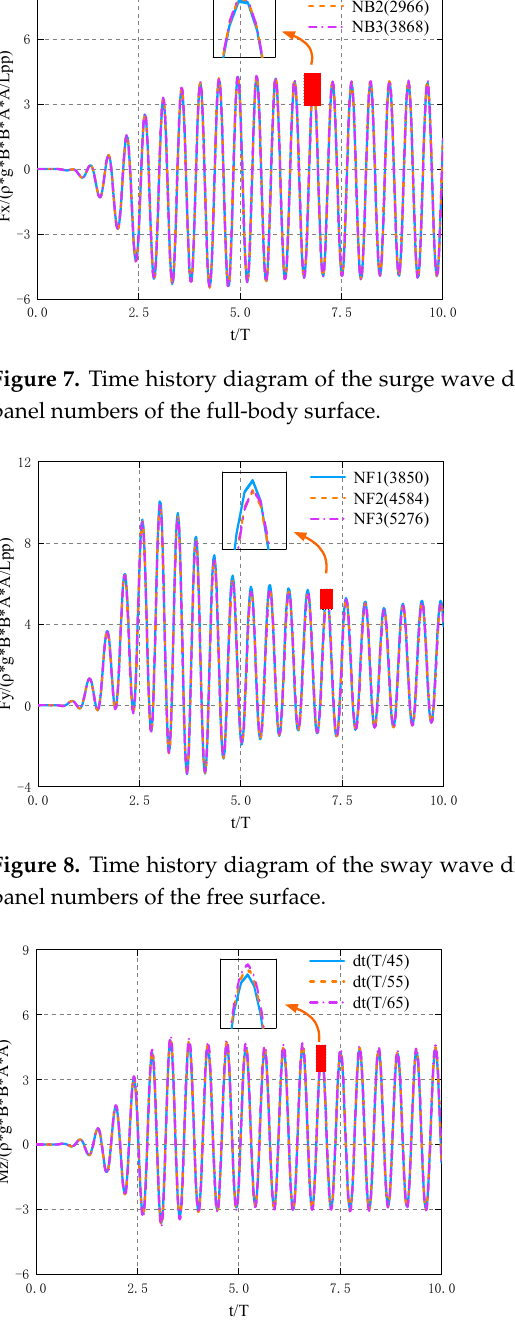
Figure 9. Time history diagram of the yaw wave drift moment of the KVLCC2 ship under different time-step scales.